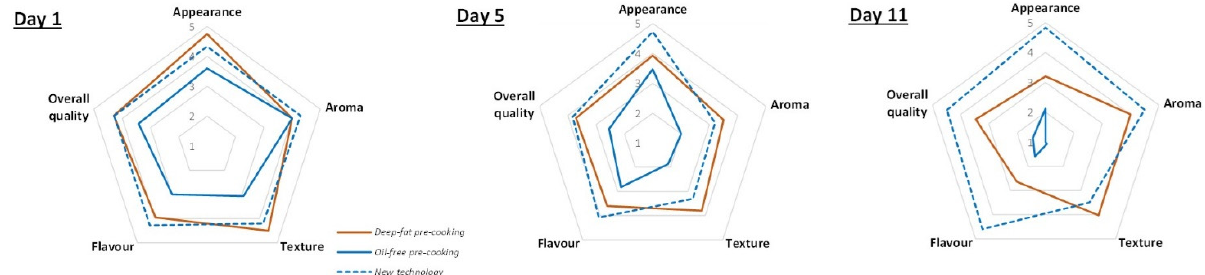
Figure 6. Sensory analyses of pre-cooked (different methods) chicken nuggets stored up to 11 days at 4 °C and cooked before sensory analysis.